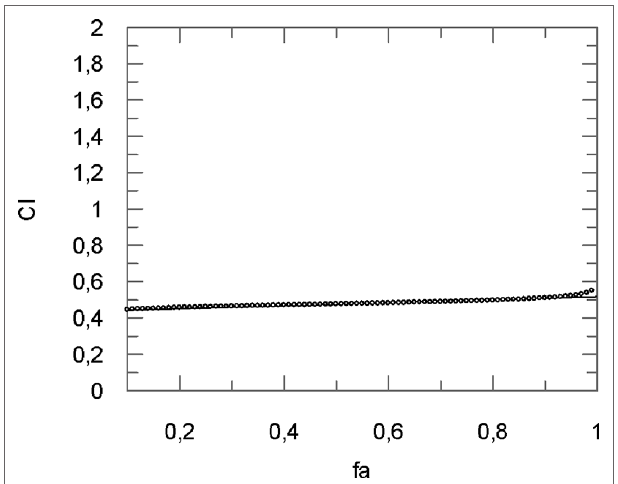
FIgURE 3 | Computer-generated graphical presentation of the combination index ( CI ) vs the fraction affected, i.e., the effect of reduction of IL-1β mRNA levels exerted by a mixture of curcumin-flavocoxid (molar ratio, 1:7.3) in chondrocytes.